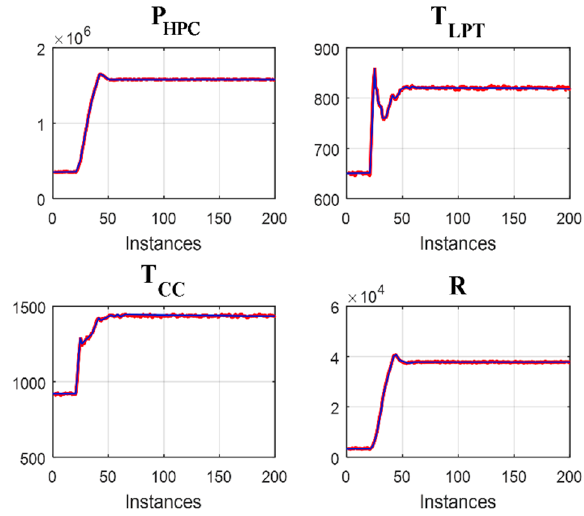
Figure 7. Initial noisy (observed) GTE variables in red color and Filtered (reconstructed) GTE variables in blue color.